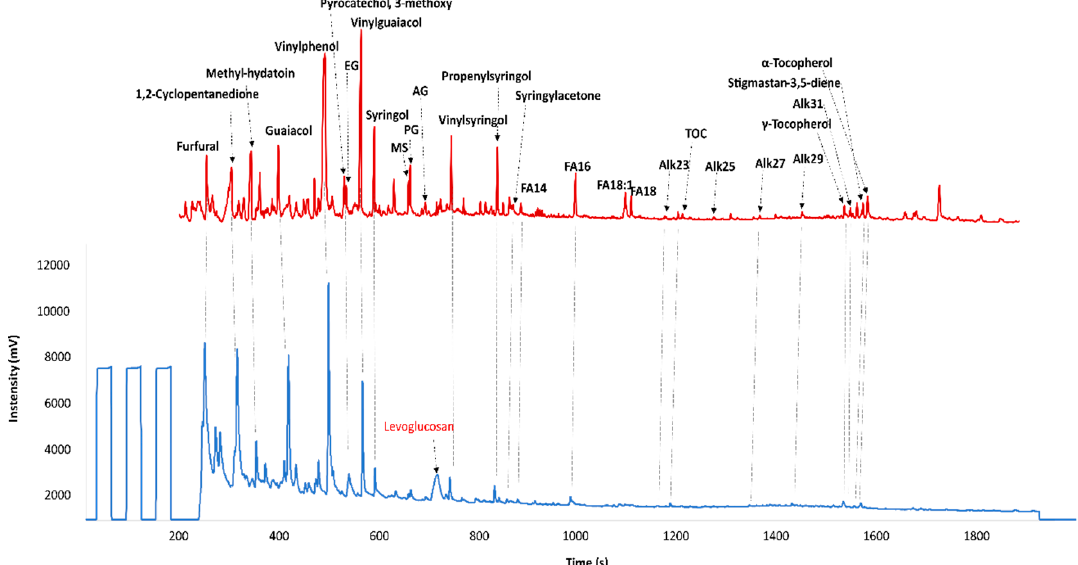
Figure 3. Example of Py-GC/MS (above in red) compound correspondence with a compound specific 𝛿 13 C chromatogram obtained by Py-CSIA (below in blue, mass 44 represented) of a representative sample of compost (T3). The three first large peaks are the reference gas signals.